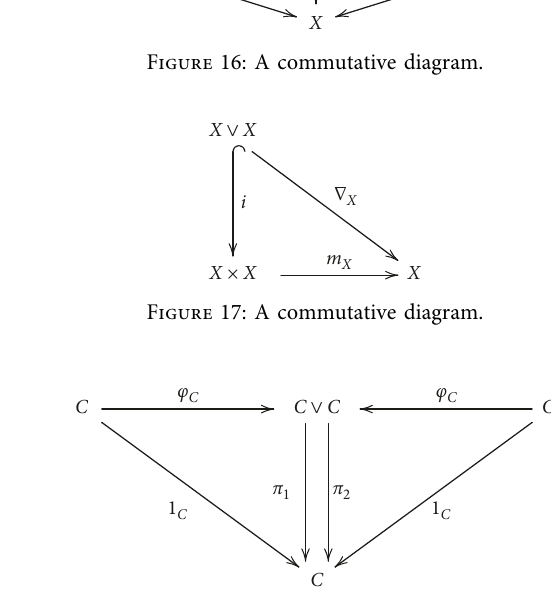
Figure 18: A commutative